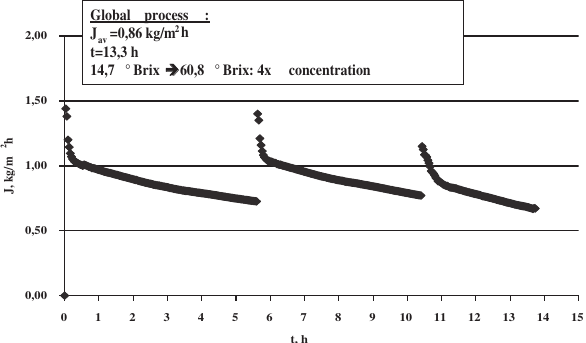
Figure 5. The concentration process of ‘Oblachinska’sour cherry juice.